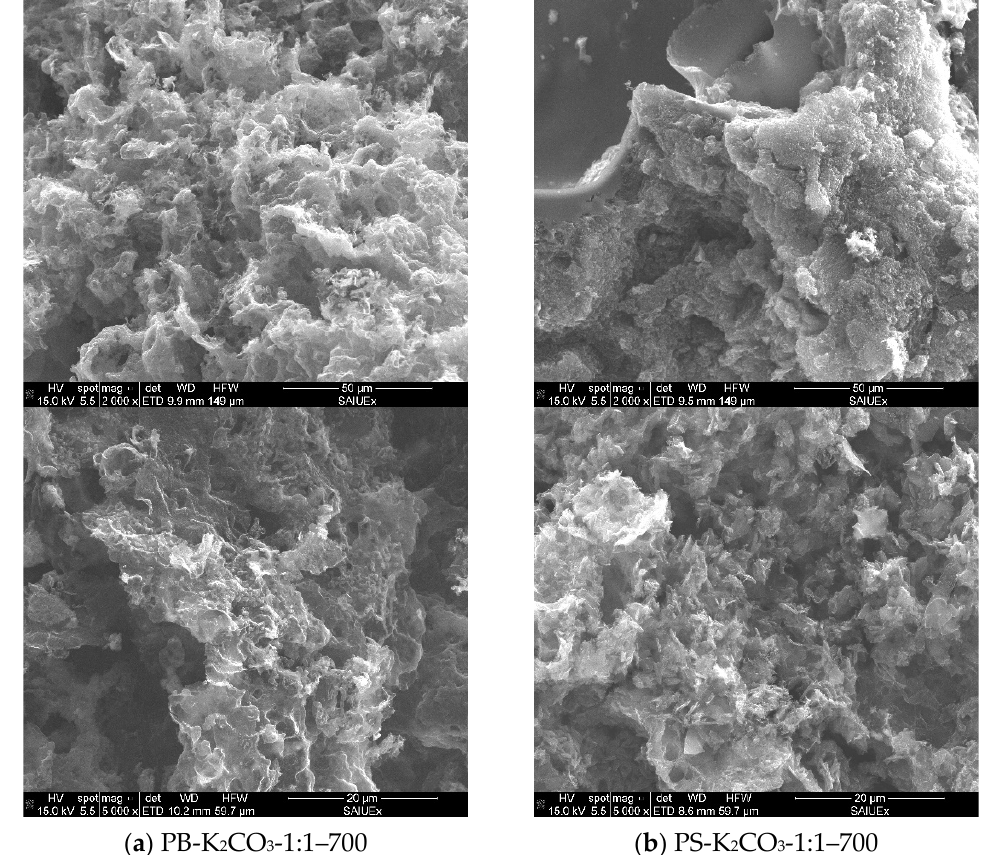
Figure 4. SEM image obtained on the ACs prepared from packing box plastics ( a ) and plastic sheeting ( b ), by chemical activation with K 2 CO 3 , at 973 K. On the images, each mark corresponds to 50 μ m and 20 μ m, respectively, on the first and second lines.